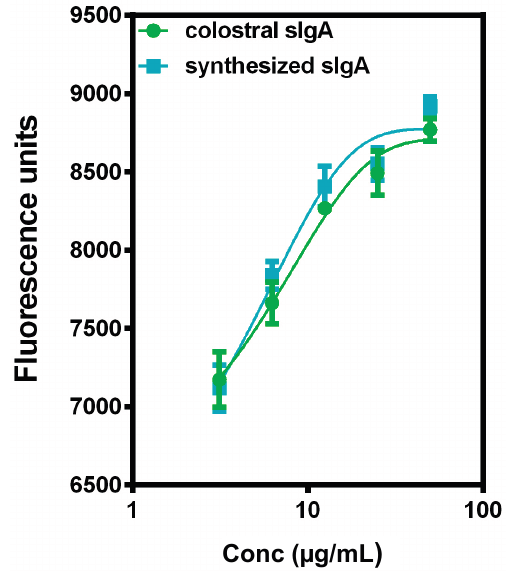
Figure 6. Figure 6 shows colostral sIgA (MP Biologicals, Solon, OH, USA) as a positive control compared with sIgA prepared from IgA dimer and recombinant human secretory component. Dimeric IgA associates with recombinant human secretory component (provided by Blaise Corthesy, Lausanne, Switzerland) to form secretory IgA . The ELISA plate was coated with mouse anti-secretory component antibody (antibodies-online, Atlanta, GA,